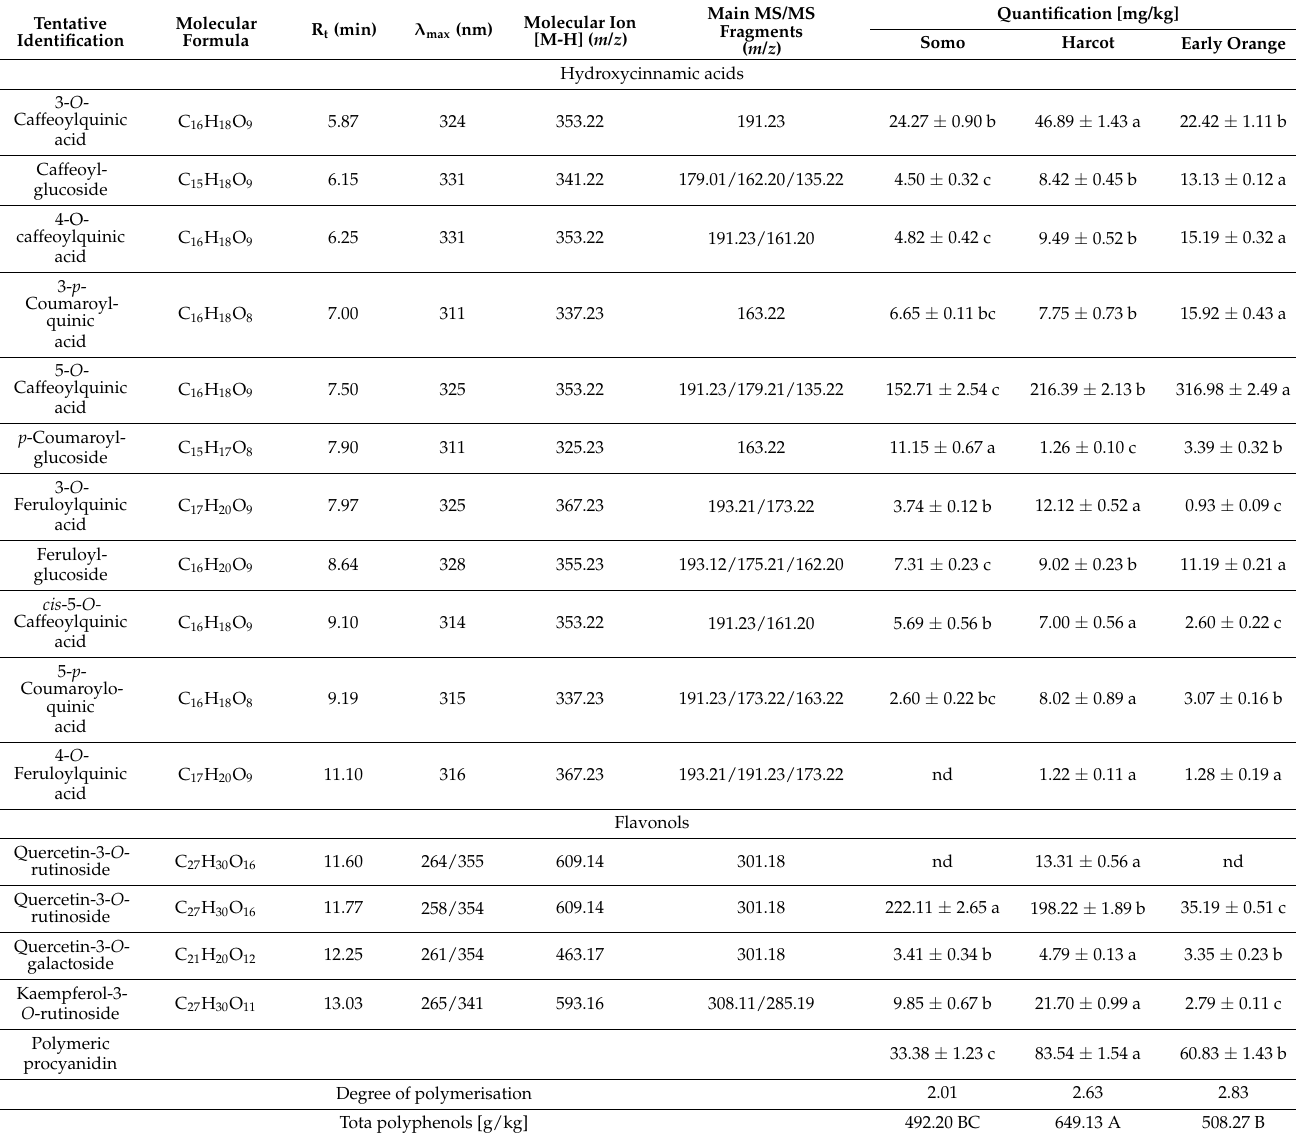
Table 1. Retention time (R t ), wavelengths ( λ max ) of maximum absorption in the visible region, mass spectral data, identifica- tion, and quantification (mean ± SD) of phenolic compounds of the PrALe by